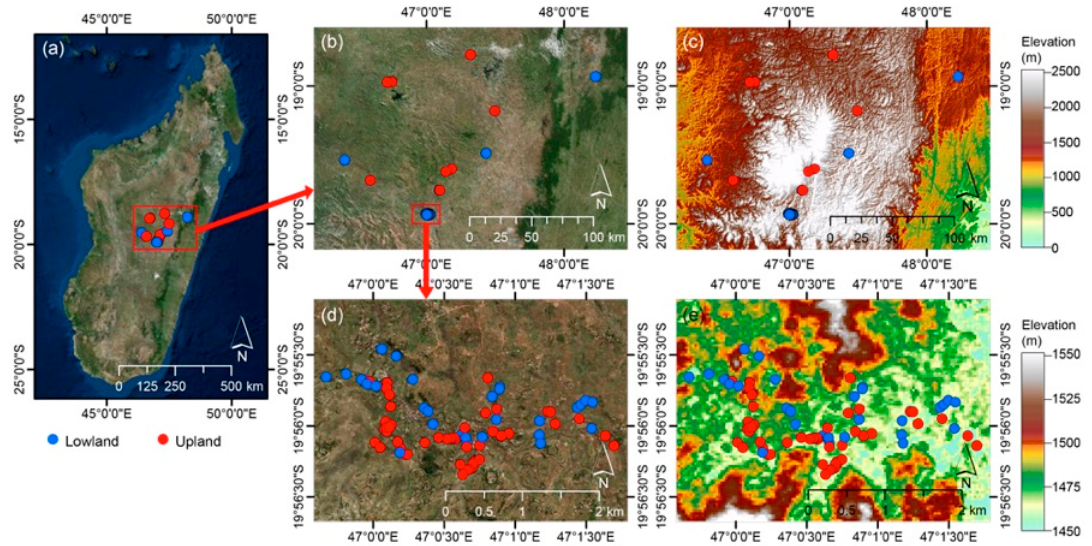
Figure 1. Location of studied regions and soil sampling points. Source in ( a ), ( b ) and ( d ): Esri, DigitalGlobe, GeoEye, Earthstar Geographics, CNES/Airbus DS, USDA, USGS, AeroGRID, IGN, and the GIS User Community. Source in ( c ) and ( e ): The ASTER GDEM version 2 data were downloaded via EarthExplore (https://earthexplorer.usgs.gov/).